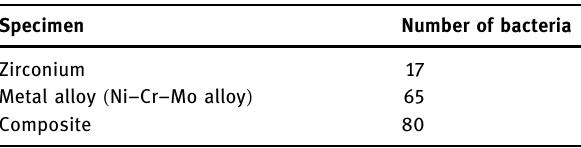
Table 4: Number of bacteria in di ff erent specimens ( zirconium, metal alloy and composite